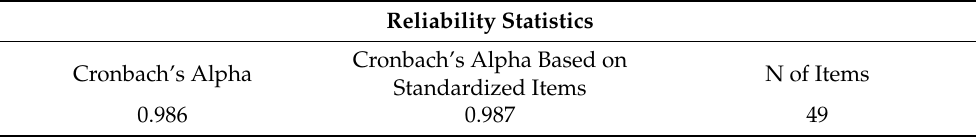
Table 4. Reliability statistics of survey data.